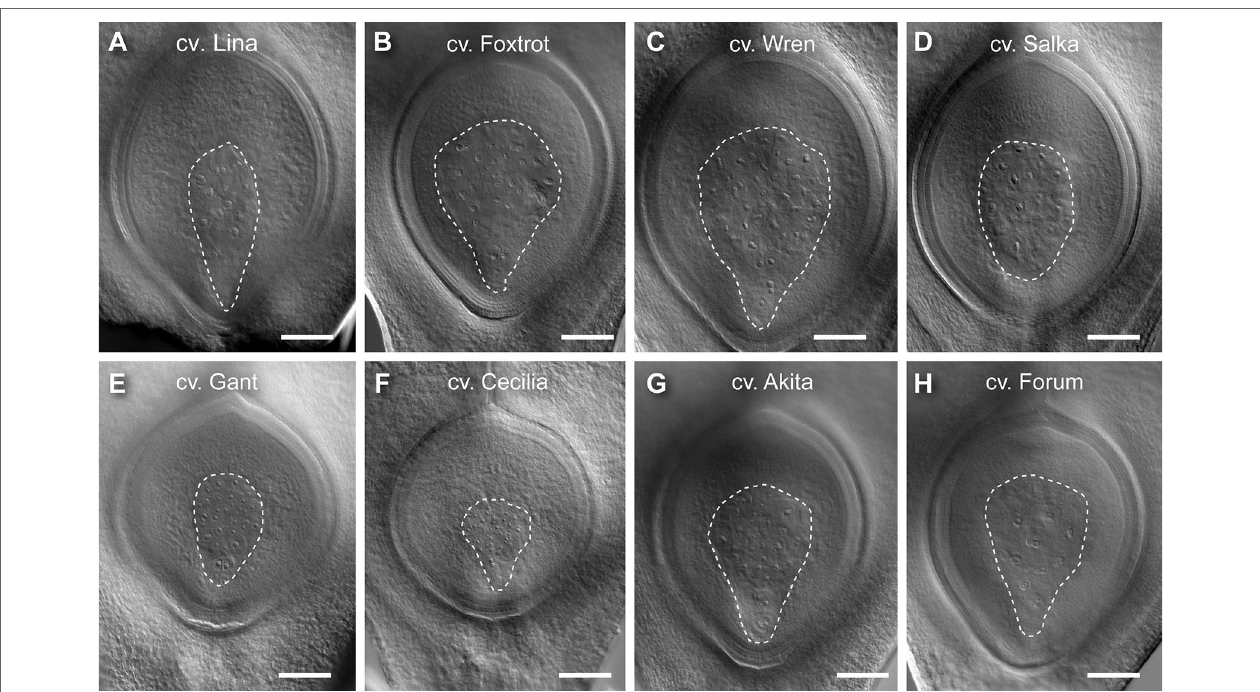
FIGURe 3 | Examples of barley genotypes showing differences in ovule morphology at maturity. (a) A representative large ovule in Lina. (B) A representative large ovule in Foxtrot. (C) A representative large ovule in Wren. (D) A representative large ovule in Salka. (e) A representative small ovule in Gant. (F) A representative small ovule in Cecilia. (G) A representative small ovule in Akita. (h) A representative small ovule in Forum. Composite images were created by overlaying sequential optical sections from the z-stack. Scale bar = 100